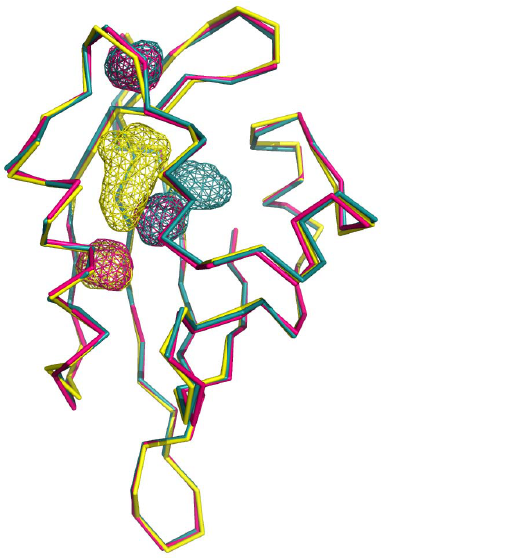
Figure S1 Sequence alignment of PAS domains from hERG, dELK, mEAG and zebra fish ERG (zfERG) channels. Highlighted residues are part of the hydrophobic core of the hERG PAS domain. Residues highlighted in green indicate positions that in dELK, mEAG and zfERG are occupied by polar residues. (TIF) Figure S2 Superposition of PAS domain structures from hERG (redbrick) and dELK (blue). Cavity in hERG is shown as redbrick wireframe. Residues in dELK which occupy the space taken by cavity in hERG are shown as blue stick with corresponding atomic Van der Waals volume as a dot representation. (TIF) Figure S3 Hydrophobic patch in channel PAS domains. View of the hydrophobic patches on the b -sheets of the PAS domain from the three different channels: a) hERG, b) mEAG and c) dELK. Residues forming patches are shown as stick and are labeled. d) Packing of N-terminal helix against hydrophobic patch in dELK PAS domain. Residues involved in interaction are shown as stick. (TIF)